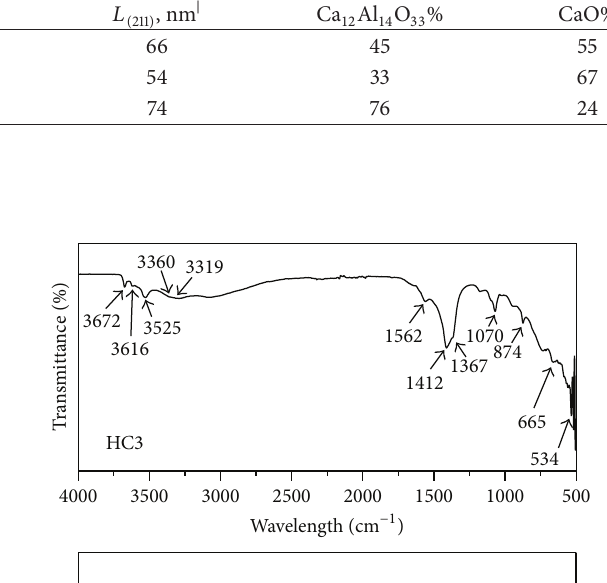
Table 2: Cell parameters, average crystal sizes, and relative crystalline phase contents of the calcined samples.